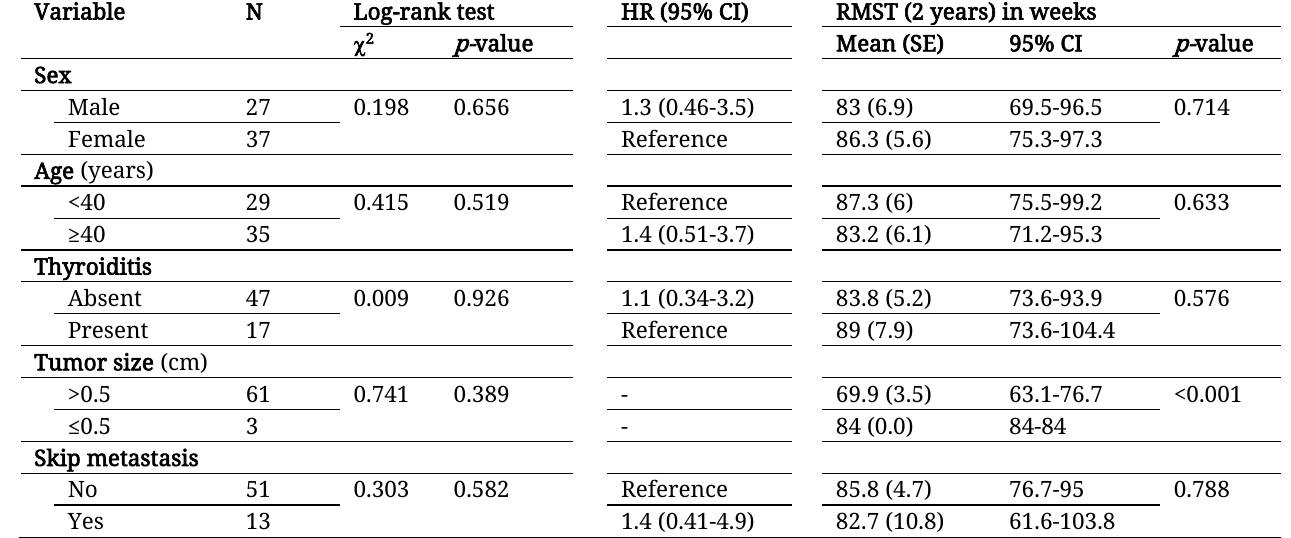
Table 3: Time-to-recurrence (TTR) analysis